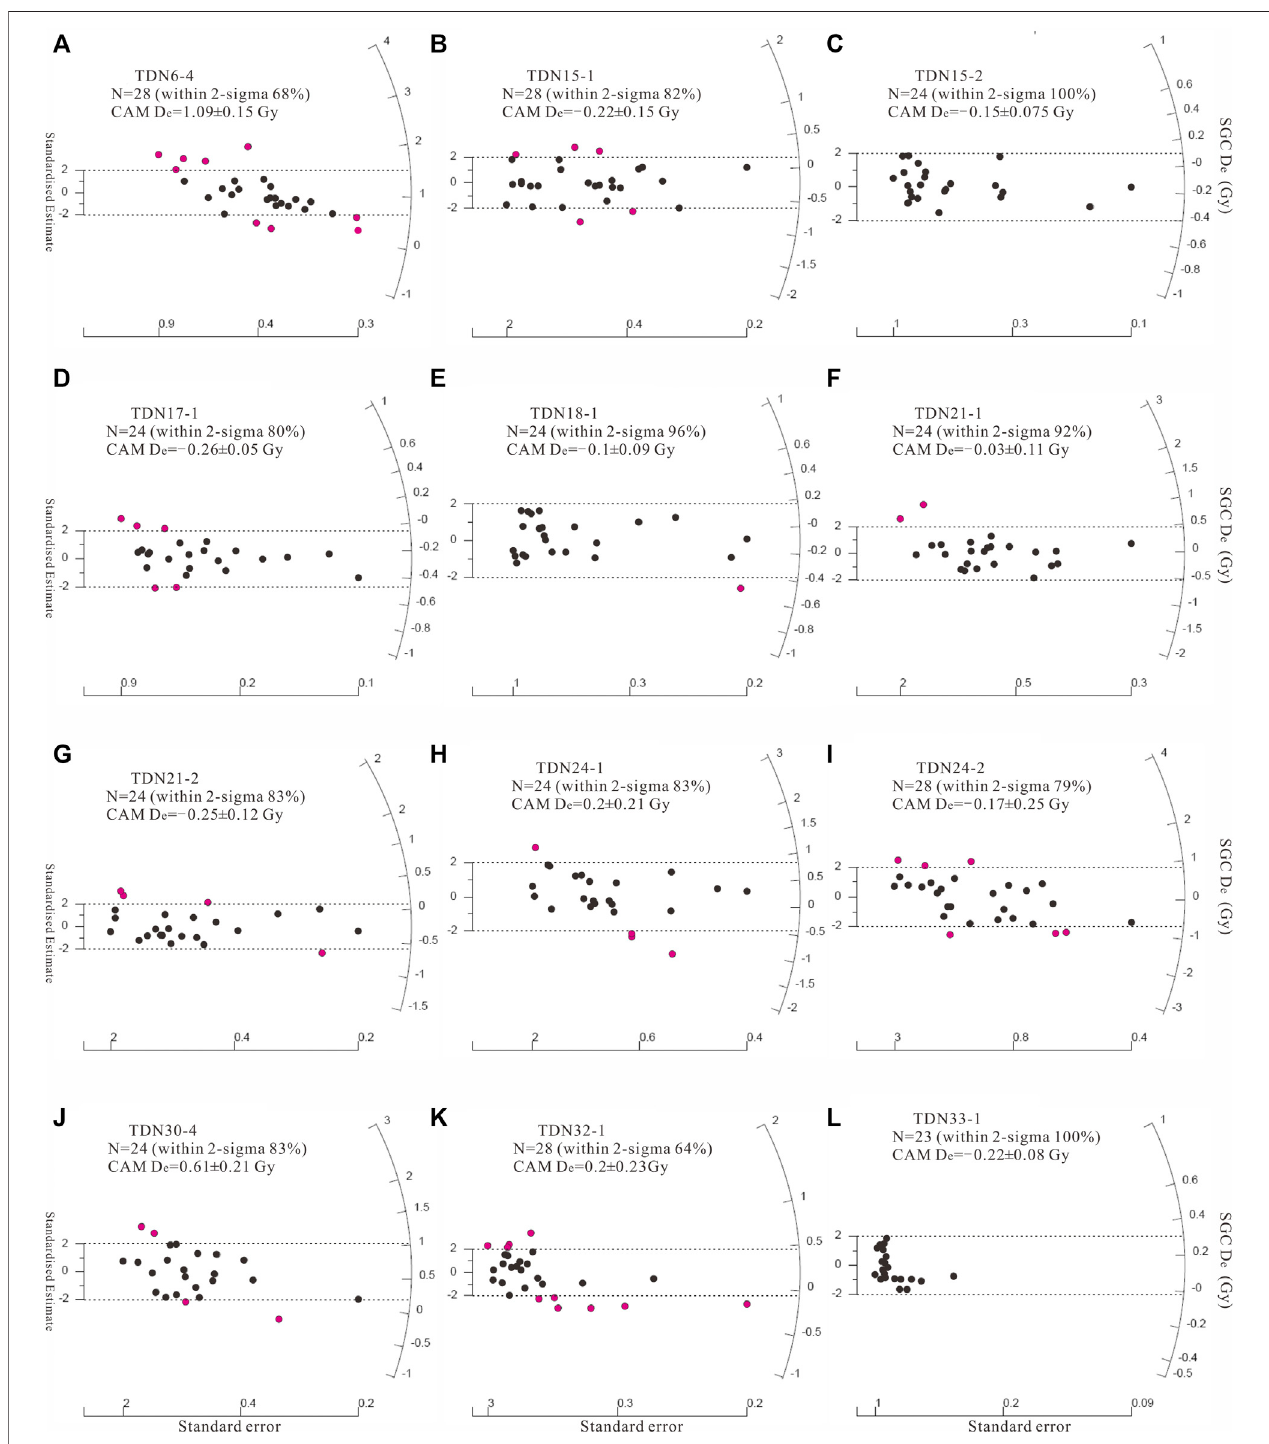
FIGURE 5 | Radial plot showing calculated SGC D e distributions of different aeolian samples. The dashed lines indicate the two sigma range of the distribution.